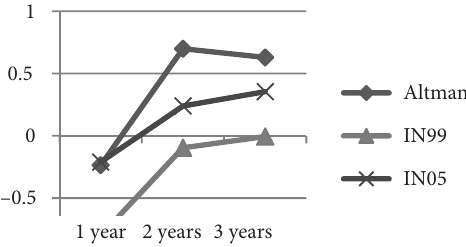
Figure 1. Time development of median values (authors based on financial statements)